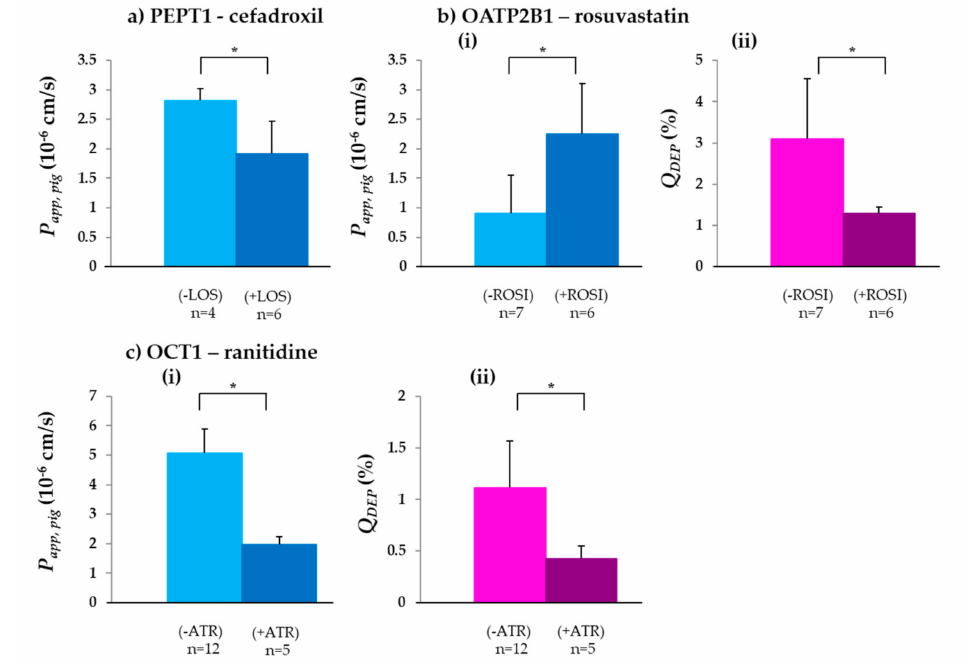
Figure 1. P app,pig and Q DEP values of three tested solute carrier (SLC) transporter substrates were significantly changed in the presence of the corresponding inhibitor: ( a ) P app,pig of the PEPT1 substrate cefadroxil in the absence ( − LOS) and presence ( + LOS) of the inhibitor losartan (LOS); ( b ) ( i ) P app,pig and ( b ) ( ii ) Q DEP of the OATP2B1 substrate rosuvastatin in the absence (–ROSI) and presence ( + ROSI) of the OATP2B1 inhibitor rosiglitazone (ROSI); ( c ) ( i ) P app,pig and ( c ) ( ii ) Q DEP of the OCT1 substrate ranitidine in the absence ( − ATR) and presence ( + ATR) of the OCT1 inhibitor atropine (ATR) (mean ± SD; n = number of replicates). * p <